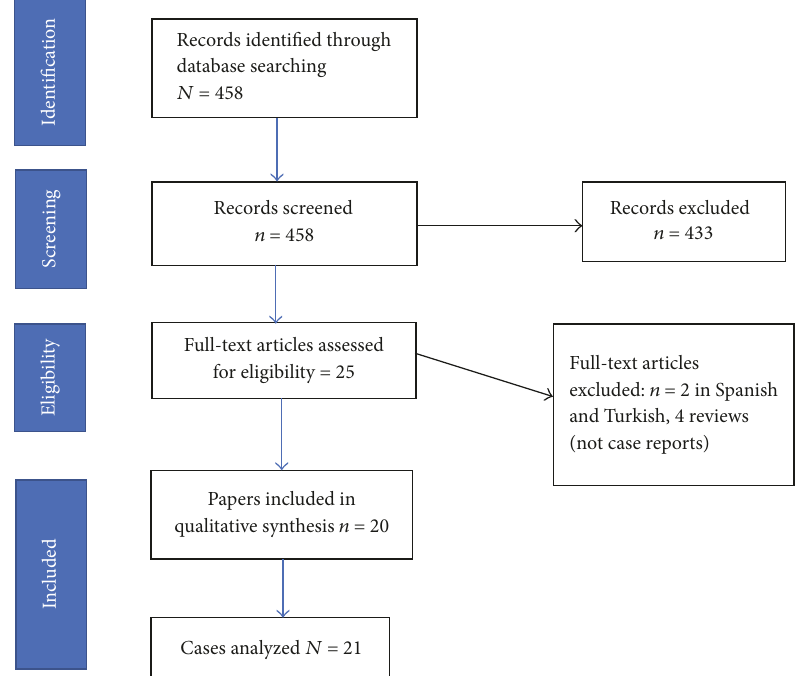
Figure 1: PRISMA flowchart: data collection and selection of